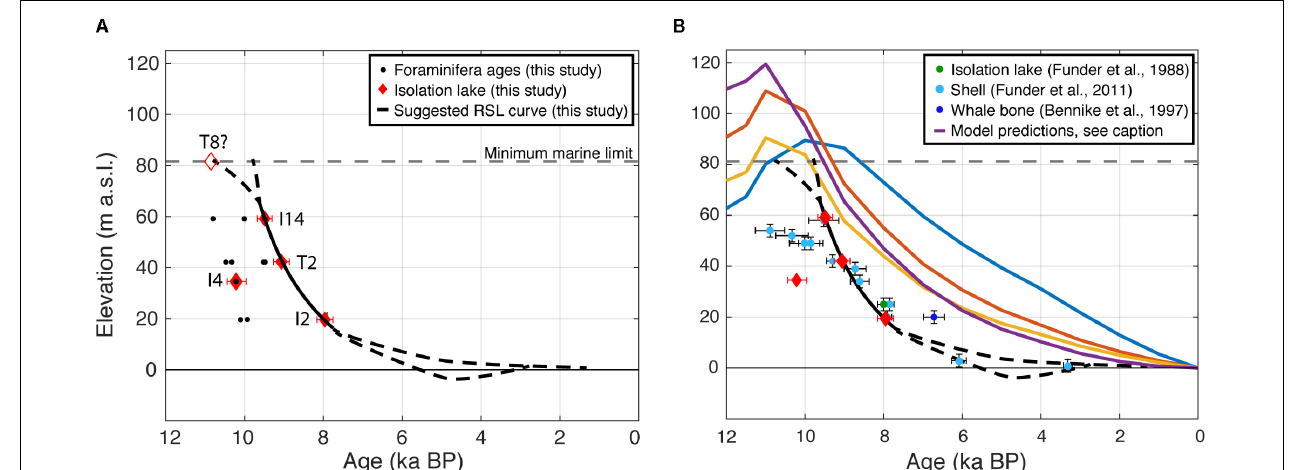
FIGURE 9 | (A) Relative sea level data for Finderup Land with foraminifera ages (black dots) and isolation lakes (red diamonds). The black line shows the, suggested relative sea level curve based on the data presented here. (B) Data from this study presented together with findings from Funder and Abrahamsen (1988); Bennike (1997), and Funder et al. (2011a). Driftwood data from Funder et al. (2011a) was omitted in this plot because it had large scatter. Solid colored lines show predicted RSL by various models. Orange: Huy2 (Simpson et al., 2009). Yellow: Huy3 (Lecavalier et al., 2014). Blue: ICE-5G (Peltier, 2004). Purple: Huy3 NGr variant (Lecavalier et al.,